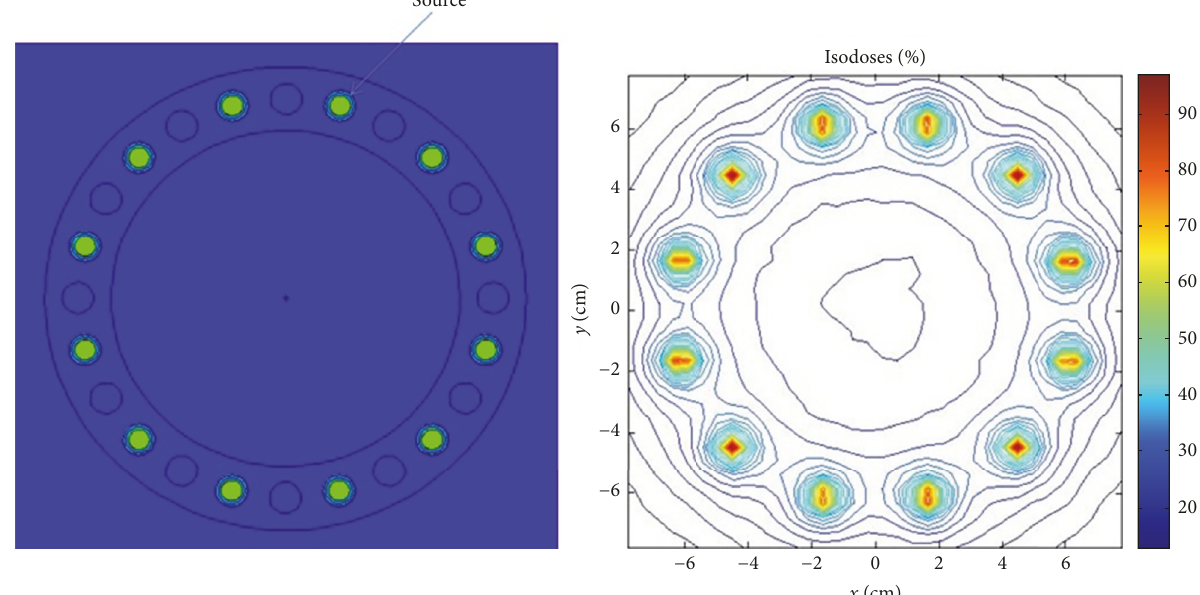
Figure 5: MCPX model and isodose curves in % representation of XY view of the gamma dose rate distribution in the GB-127 source.